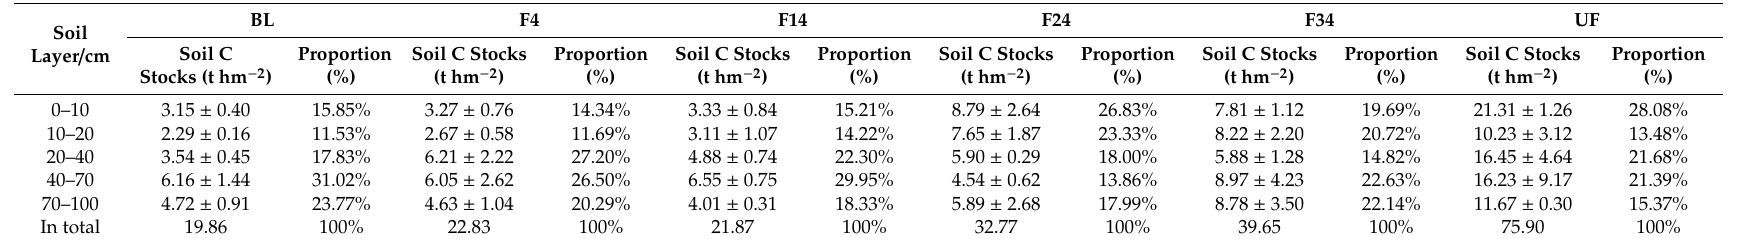
Table 3. The SOC storage and proportions of di ff erent soil layers to the 1 m depth soil profile.